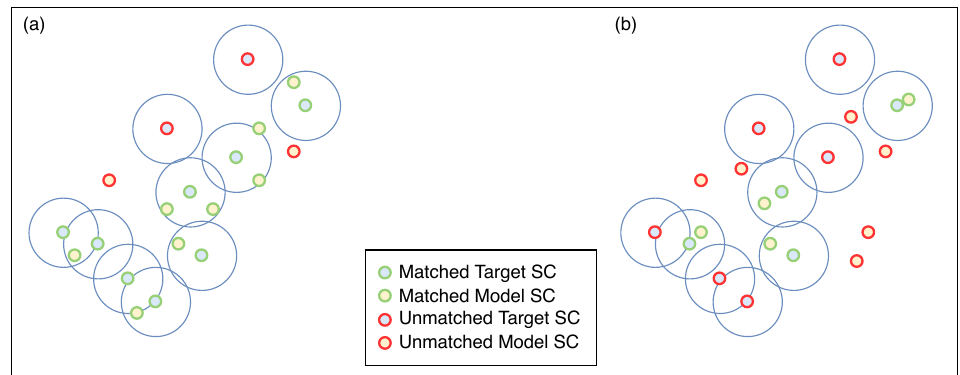
Figure 4. Neighbor Matching Algorithm applied to ( a ) the true class and ( b ) a false class. Unlike these approaches, the proposed algorithm does not need to assign pairs of scattering centers or perform morphological or filtering operations; it is directly applicable, simple and fast, as the features are the scattering centers